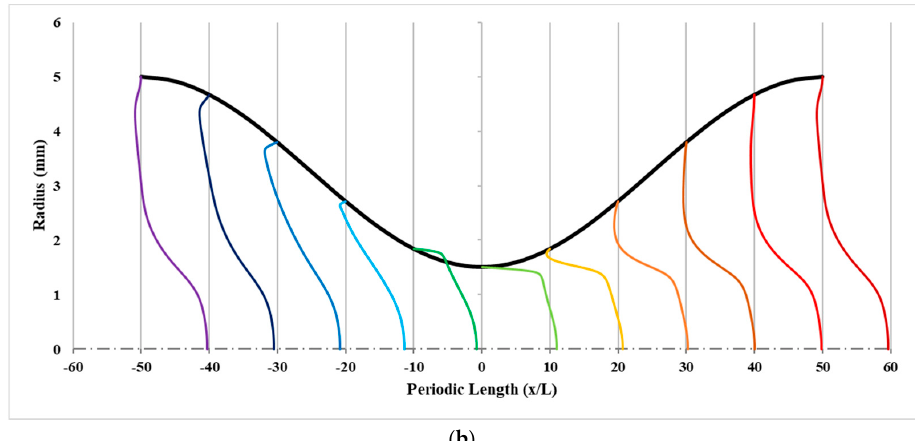
Figure 4. Velocity profile (scaled) for wavy-walled tube ( a ) F w = 0.58 and Re D = 100 (Laminar) and ( b ) F w = 0.58 and Re D = 1000 (Turbulent).